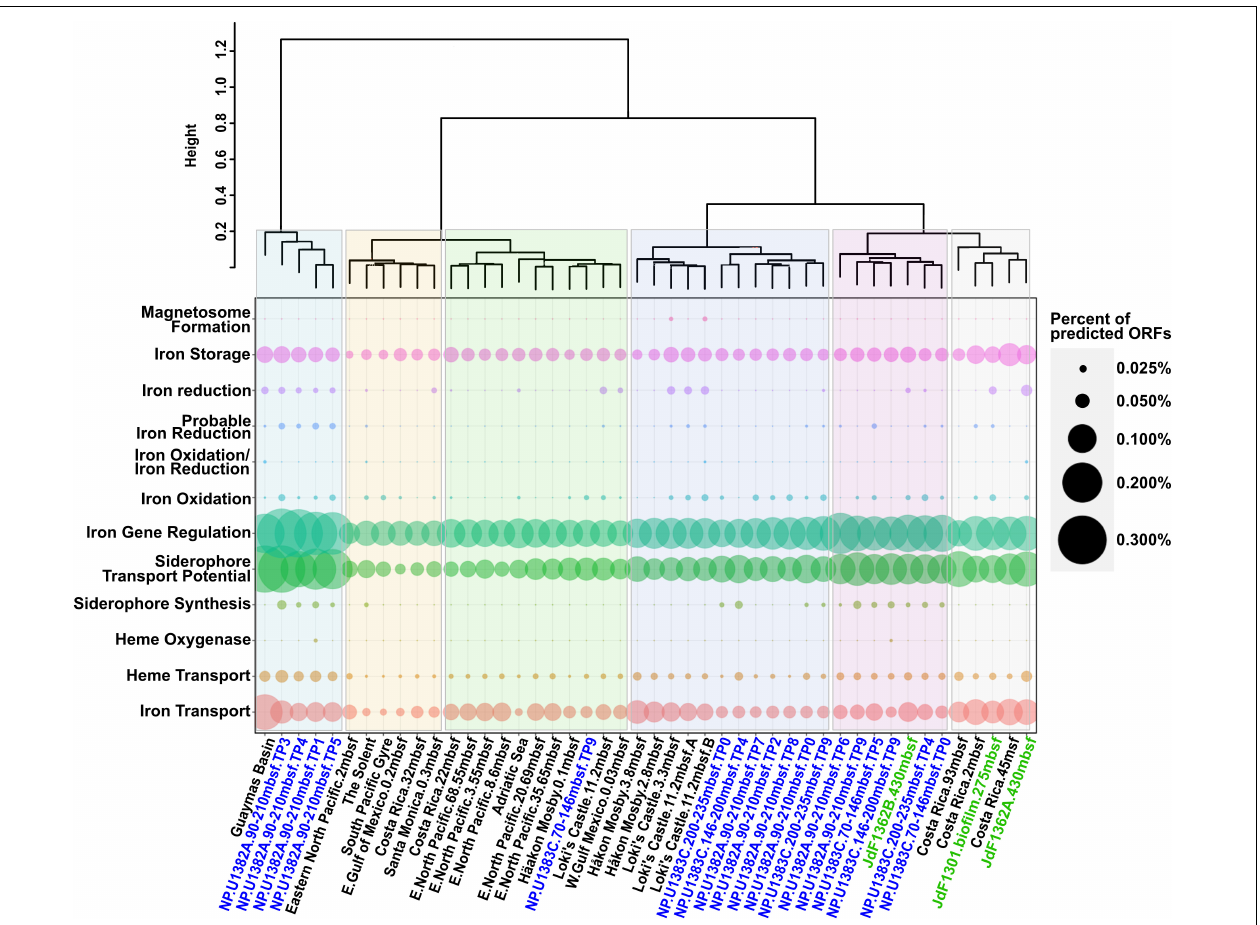
FIGURE 2 | Dotplot summary of iron genes in marine subcrustal aquifers and sediment identified by FeGenie, showing the variation among iron genes from different time points from North Pond. North Pond metagenomes are colored blue, while metagenomes from the Juan de Fuca ridge are colored green. Metagenomes derived from sediment samples are colored black. While certain pathways appear to be universal (iron acquisition and storage), other processes appear to vary in abundance (iron redox cycling and siderophore synthesis), while others still (magnetosome formation and heme oxygenases) appear to be quite rare. “Percent of predicted ORFs” was calculated by dividing the total number of genes identified from each iron gene category by the total number of predicted ORFs from each respective